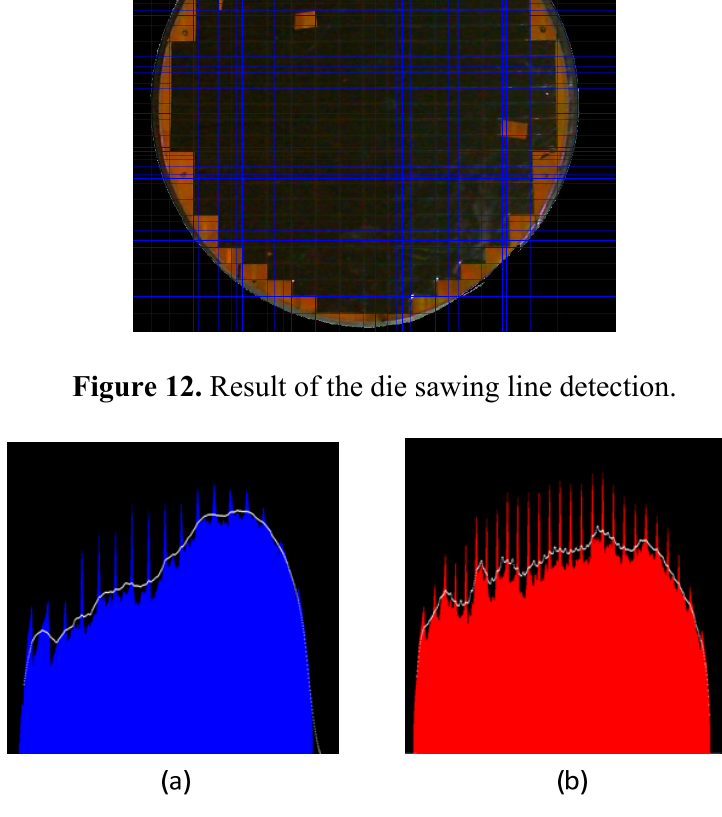
Figure 13. The result of the average line method: ( a ) average values shown on a white line in the vertical direction; ( b ) average values shown on a white line in the horizontal